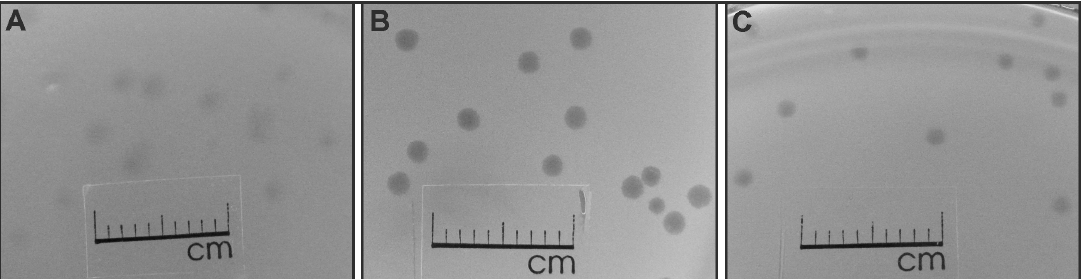
Figure 1. The morphology of VpaE1 plaques produced on the lawns of E. coli BL21 at different temperatures. Plaques are shown after: ( A ) five days of incubation at 9 °C; ( B ) 24 h of incubation at 37 °C; and ( C ) 24 h of incubation at 47 °C.